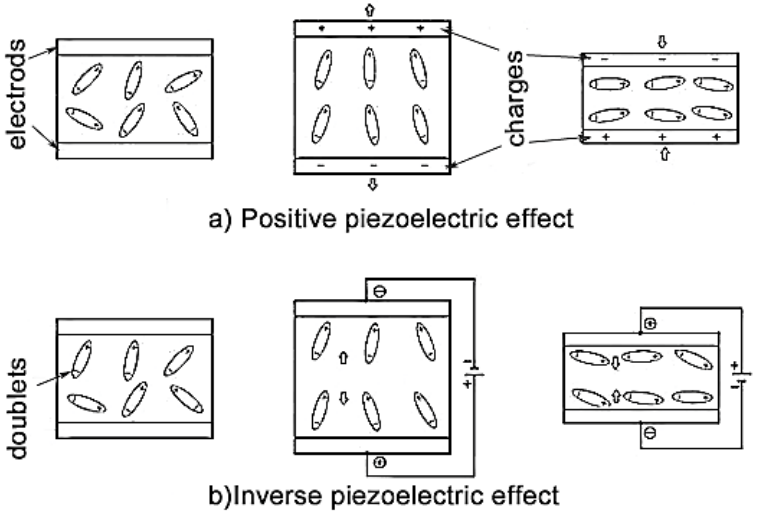
Figure 3. Schematic diagram of piezoelectric effect.